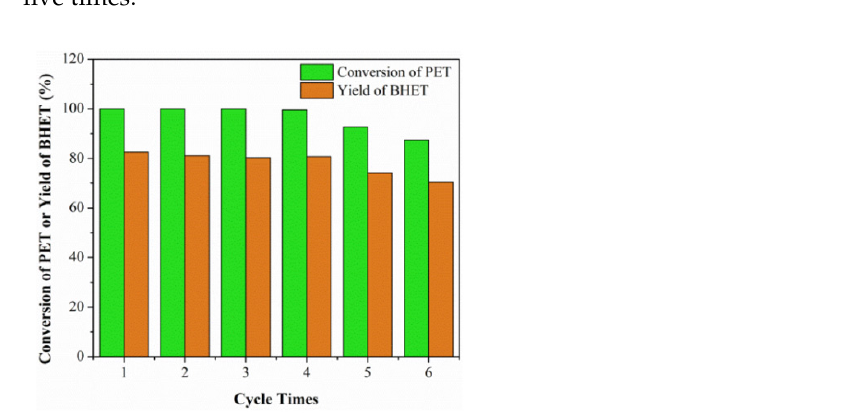
Figure 17. Recycling efficiency of the employed catalyst. Reprinted from reference [81] with per- mission.